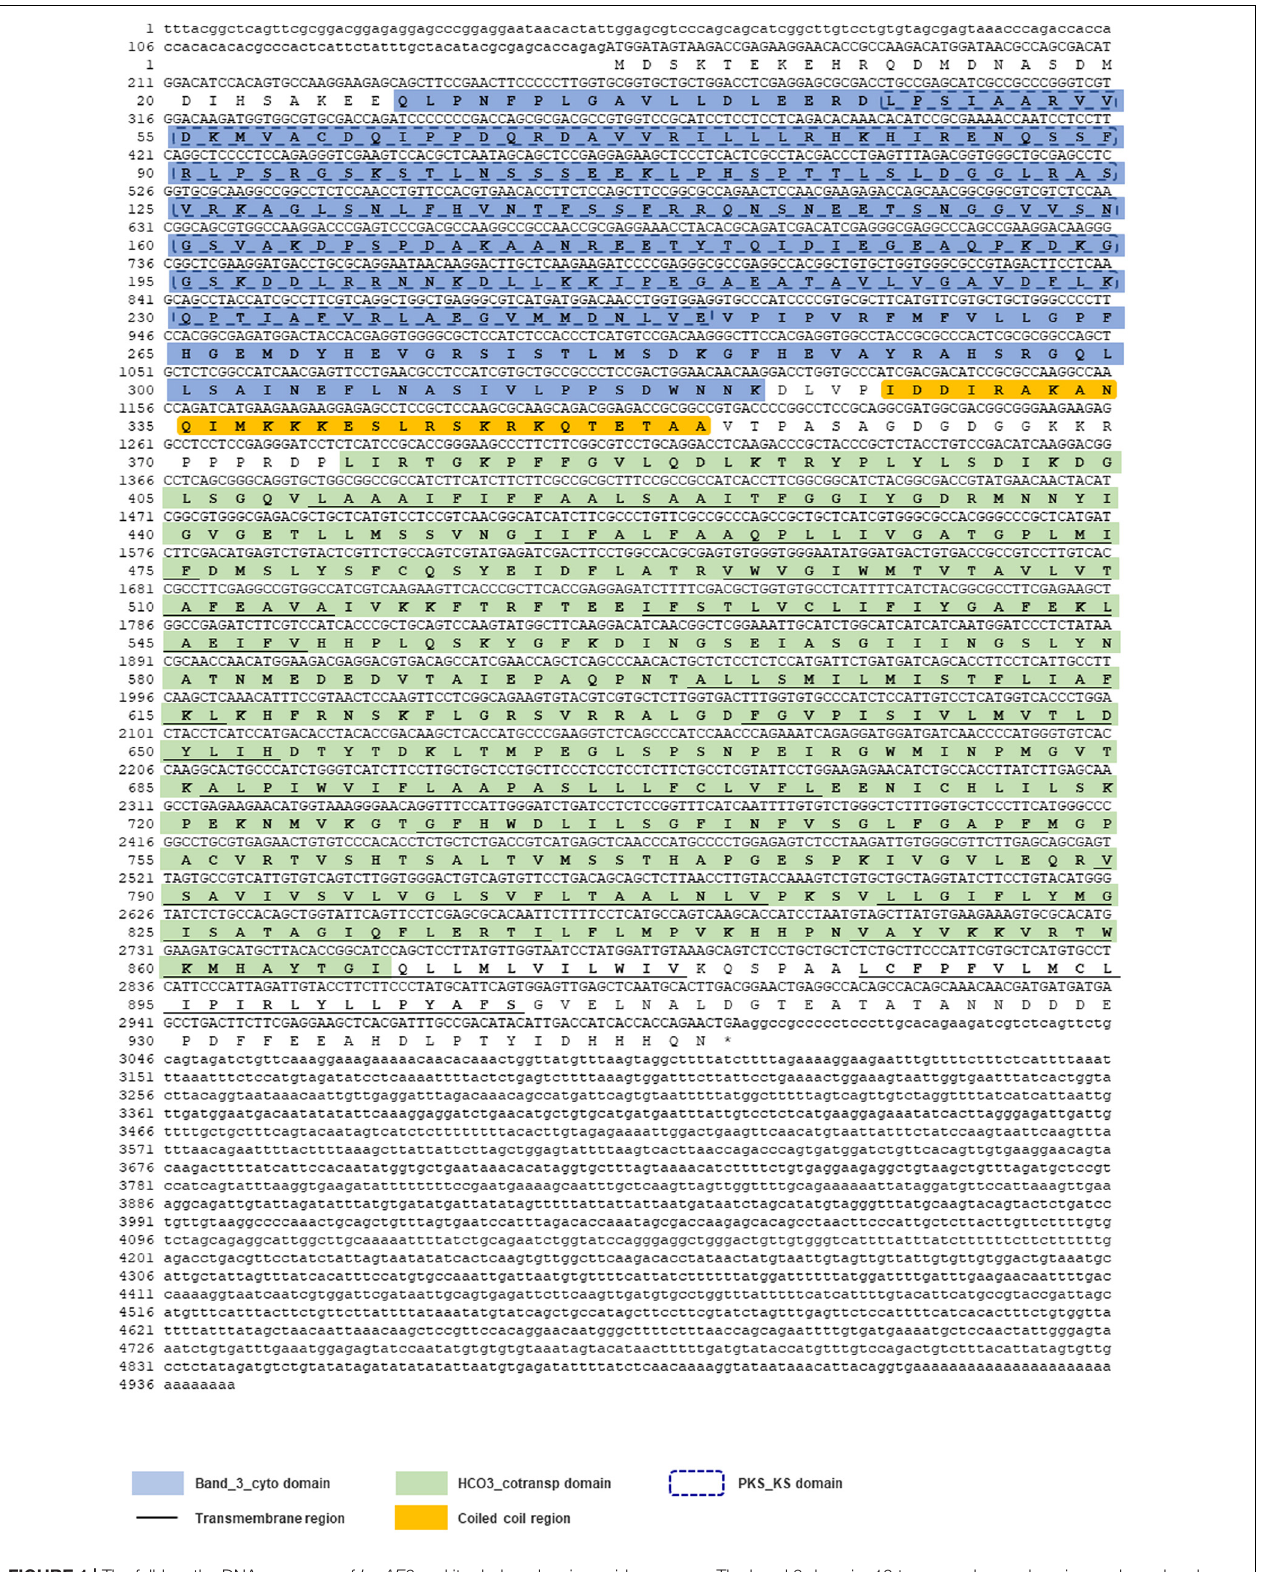
FIGURE 1 | The full-length cDNA sequence of Lv-AE3 and its deduced amino acid sequence. The band 3 domain, 12 transmembrane domains are boxed and indicated.